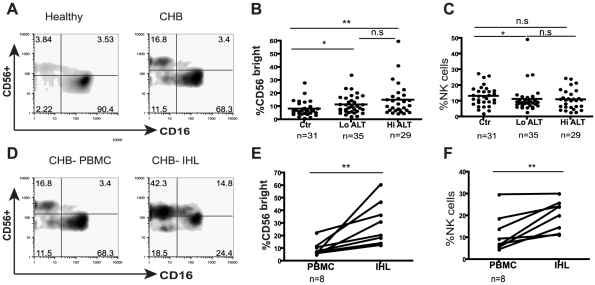
NK cell frequency and altered subset distribution in the periphery and intrahepatic compartment.(A) Representative density plots gated on CD3- PBMC and co-stained for CD56 and CD16 to identify NK cells from a healthy control and a CHB patient. (B) Summary data of the proportions of CD56bright subset in the periphery of CHB patients with low ALT (n = 35, ALT <50IU/L, median 34) compared to high ALT (n = 29, median ALT 112) and healthy controls (n = 31). (C) Frequency of circulating NK cells in CHB patients with low ALT and high ALT and healthy controls. (D) Density plots of NK cells from peripheral blood and intrahepatic lymphocytes from a representative CHB patient. (E) Paired cumulative results of peripheral and intrahepatic CD56bright NK cells frequencies from 8 patients with CHB. (F) NK cell frequency in peripheral blood and intrahepatic compartment from 8 patients with CHB with paired samples. The non-parametric Mann-Whitney U test was used to compare data between groups and the Wilcoxon signed rank test was used between paired variables. *p<0.05 or ** p<0.01 designates values that differ significantly between groups. Ctr  =  healthy controls.